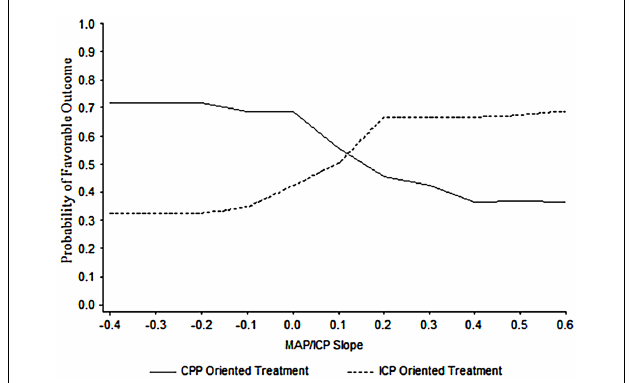
FIGURE 13 | BANN generated probability distribution plots for the mean likelihood of a favorable clinical outcome for patient populations managed in two different centers . In this data, the optimal point at which to switch from one treatment strategy to the other in a given patient is at an MABP/ICP trend with a slope of approximately 0.13.Taken from Howells et al.